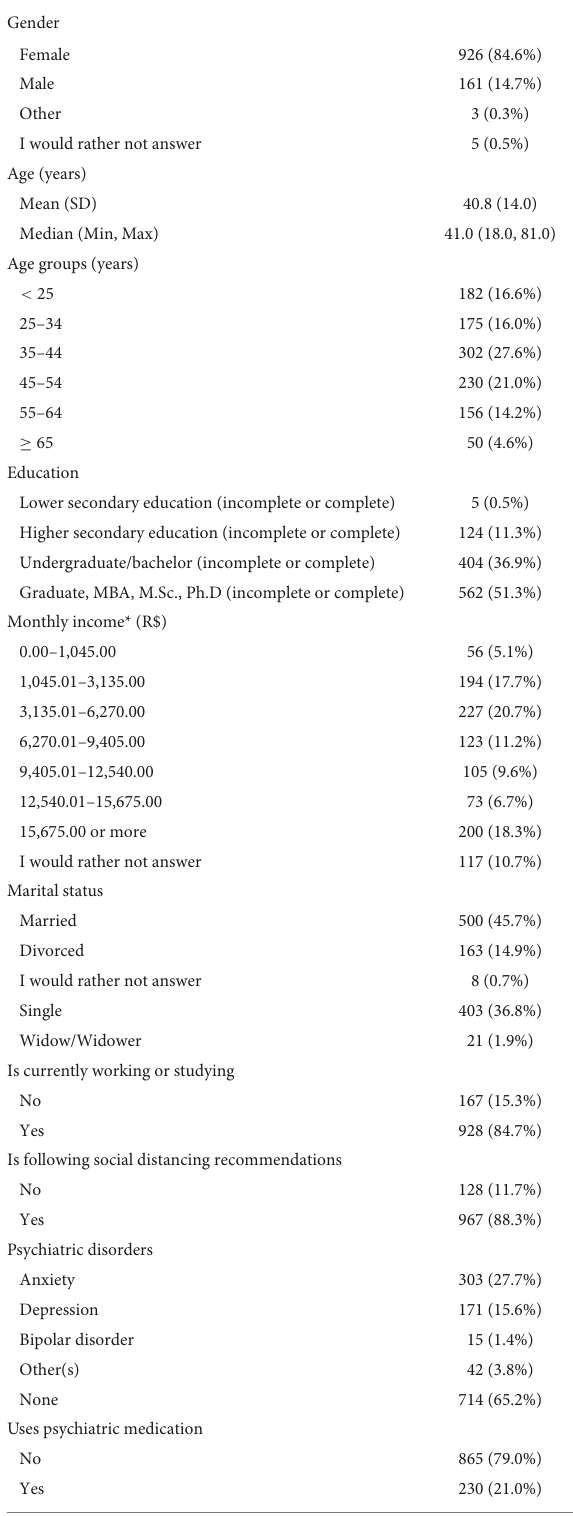
Table 2 presents clinical and sociodemographic variables for both Keep and Change groups and also according to their baseline main emotion (positive or negative). The Keep group comprises 31% of the